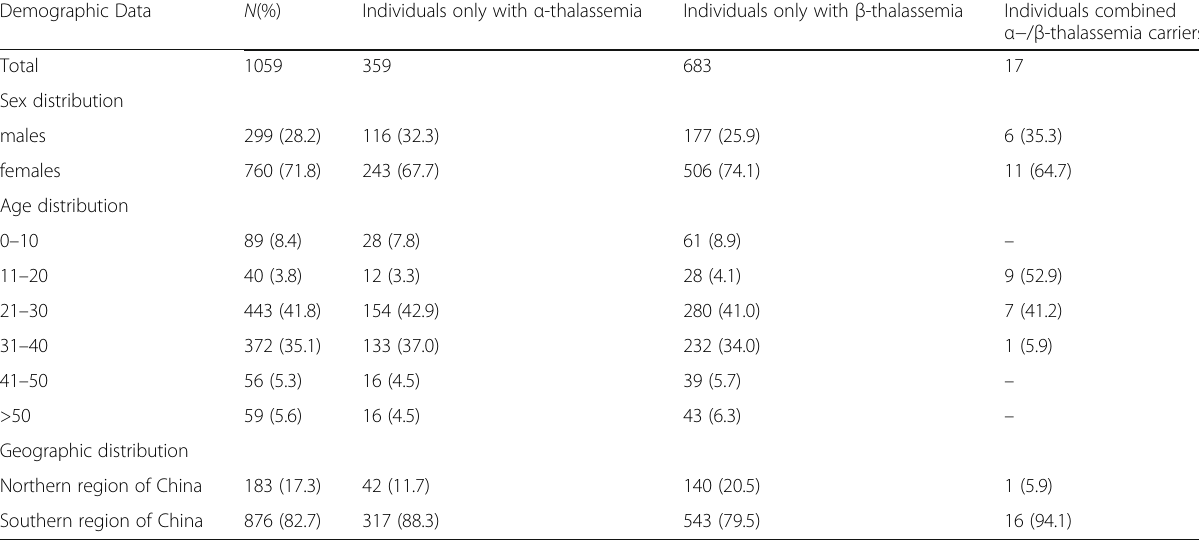
Table Legend: N=number of patients; %=number of events/total number of patients in